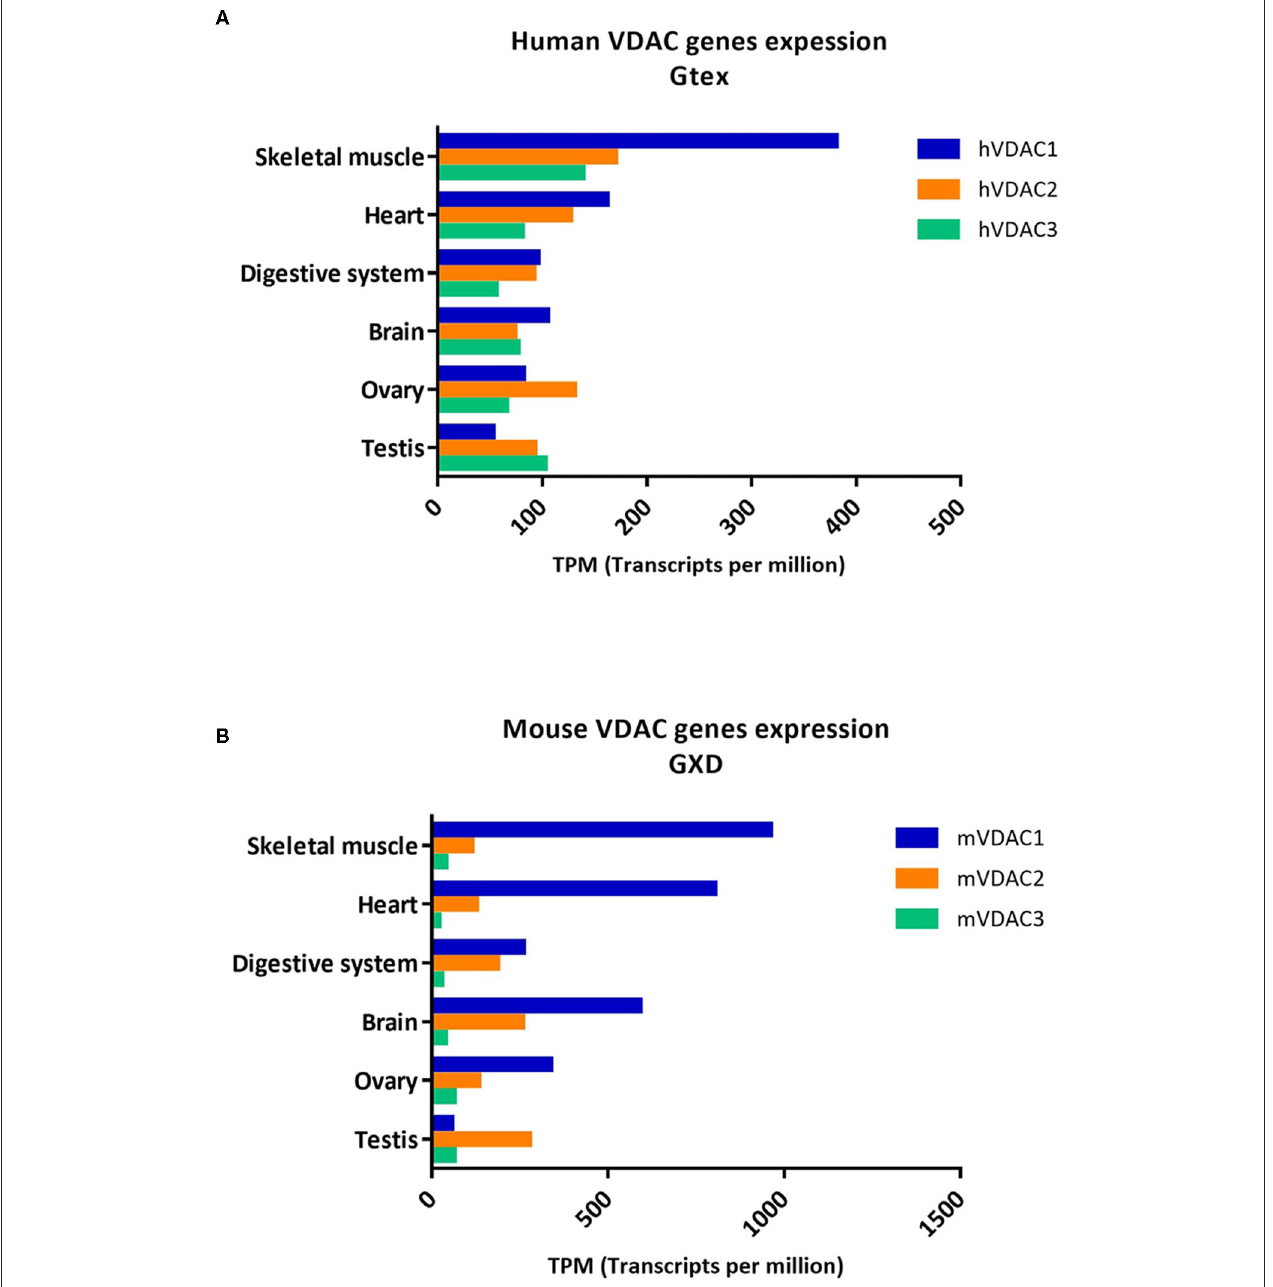
FIGURE 2 | Human and mouse VDAC isoforms genes expression in different tissues. The expression level of human and mouse VDAC genes in the most common tissues as obtained from (A) Genotype-tissue expression (GTEx) related to expression Atlas of EMBL-EBI open science resource (https://www.ebi.ac.uk/gxa/home); and from (B) MGI-Mouse gene expression database (GXD)